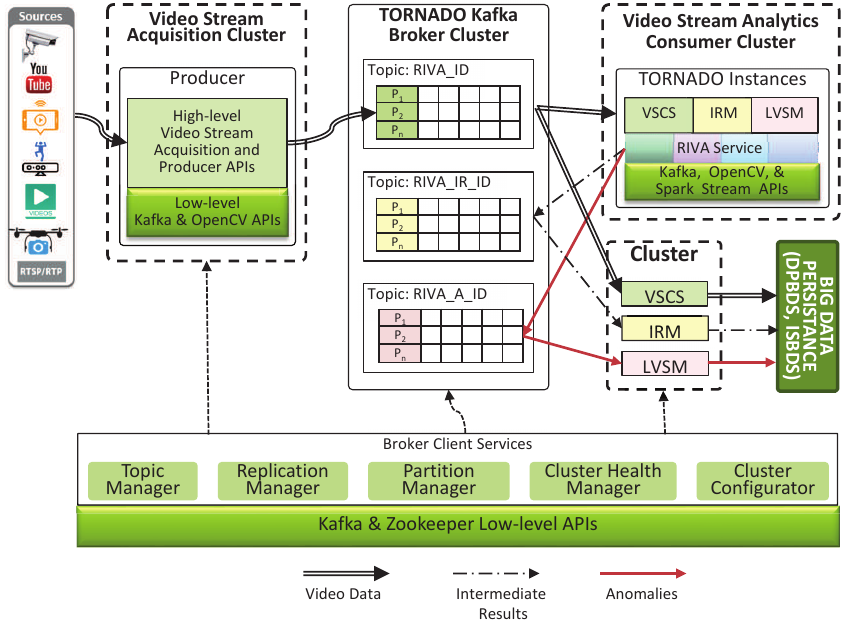
Figure 5. Video Stream Acquisition and Synchronization